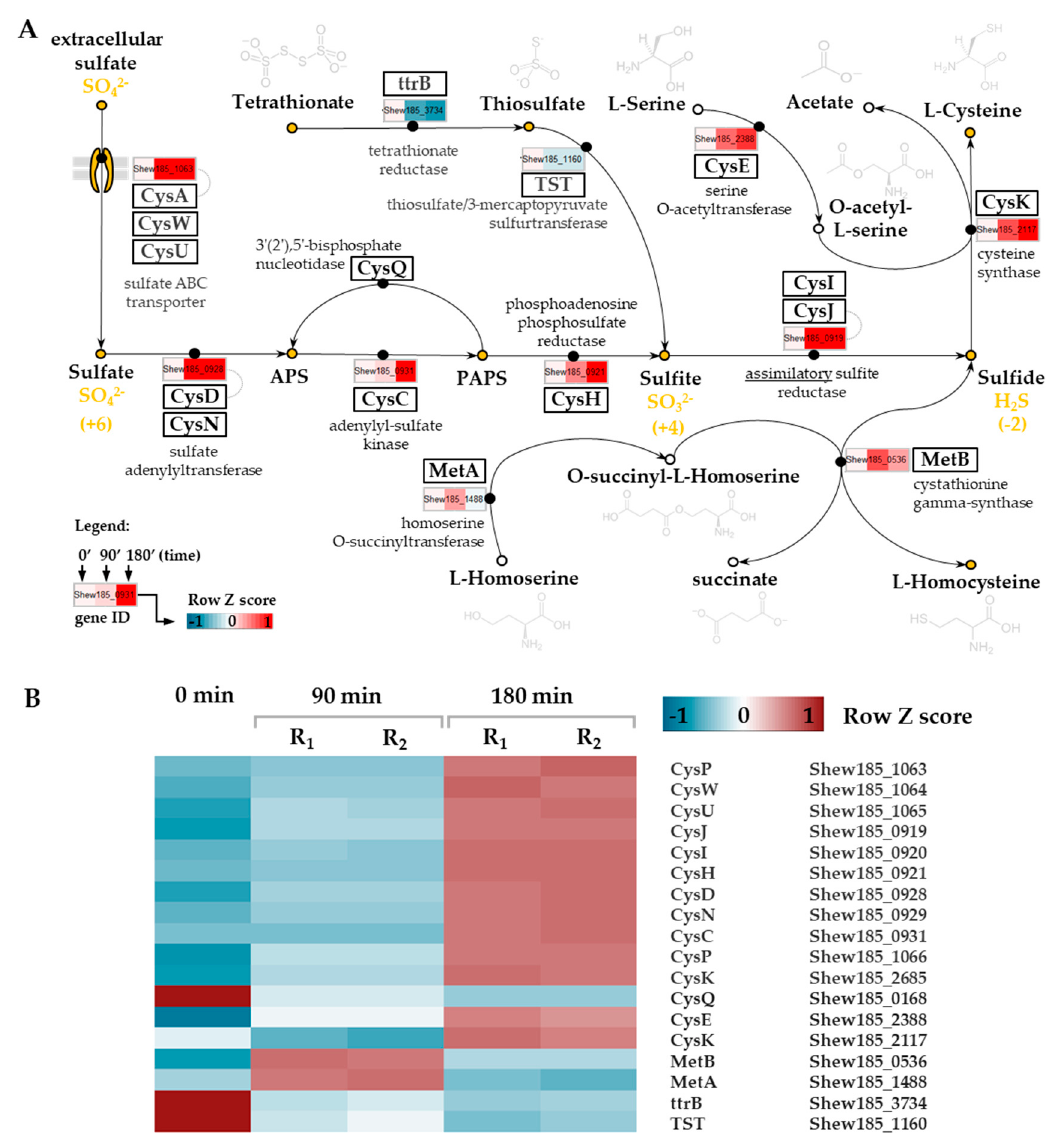
Figure 5. Expression changes in S. baltica sulfur metabolism processes upon cold stress. ( A ) Simplified scheme of sulfur assimilatory pathway and a fragment of serine, homoserine and cysteine metabolism pathways are presented (based on: KEGG database). Tripartite heatmap boxes, fixed on affected pathways (full black circles), show row Z-score scaled normalized expression values for corresponding genes upon cold stress at 0, 90 and 180 min time points, respectively. Names of specific enzymes or subunits are shown next to the relevant gene names (black boxes). Yellow circles represent sulfur-containing compounds. Oxidation states and formulas (in yellow) are shown for key inorganic sulfur compounds—sulfate, sulfite and sulfide. ( B ) Heatmap showing row Z-score scaled normalized expression for corresponding genes. Column 0 stands for control sample; replicates for 90 and 180 min time points are labeled R 1 and R 2